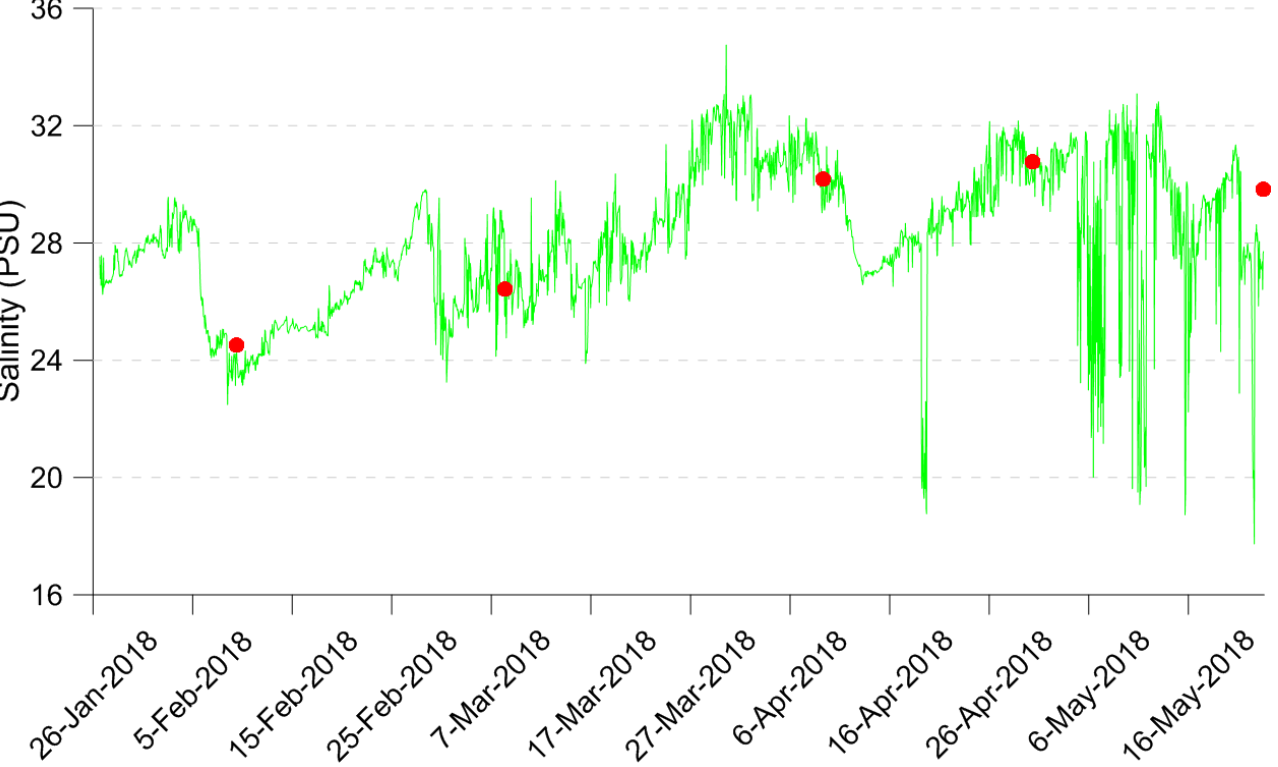
Figure 7. Hourly salinity measured at location 20 (Figure 2) from 26 January 2018 to 23 May 2018. Monthly in situ salinity measurements at location 9 are also represented.